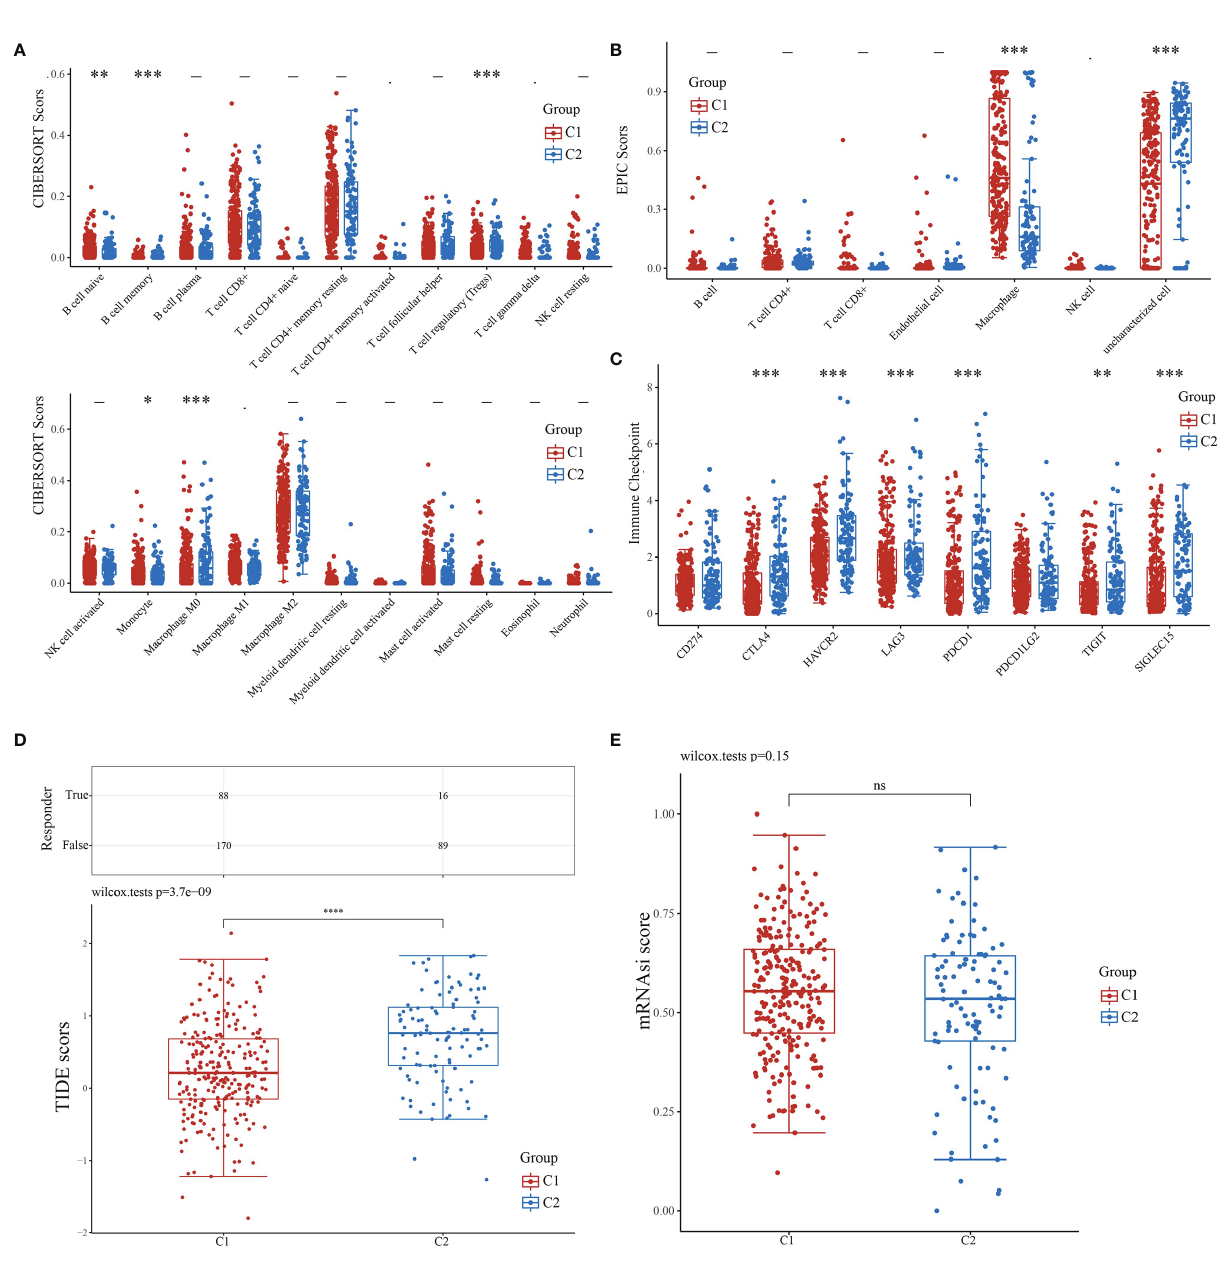
( Figure S2E ). These results demonstrated that the expressions of speci fi c neural-related genes including CHRNE , GFRA2 , GFRA3 , and GRIN2D might be potential biomarkers for LIHC prognosis.